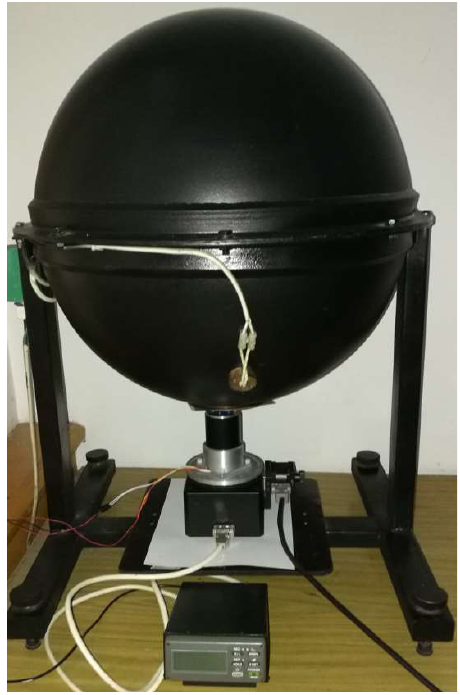
Figure 15. Photograph of indoor calibration setup.